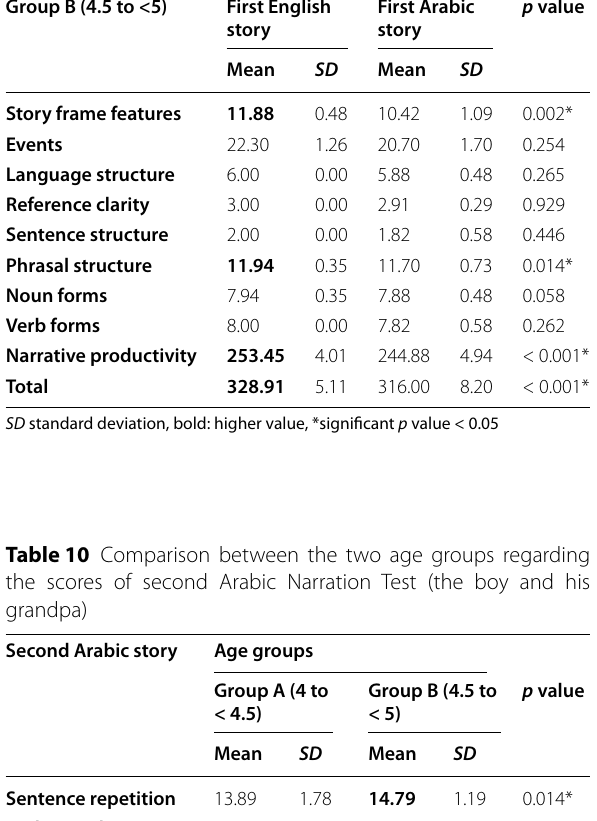
SD standard deviation, bold: higher value, *significant p value < 0.05